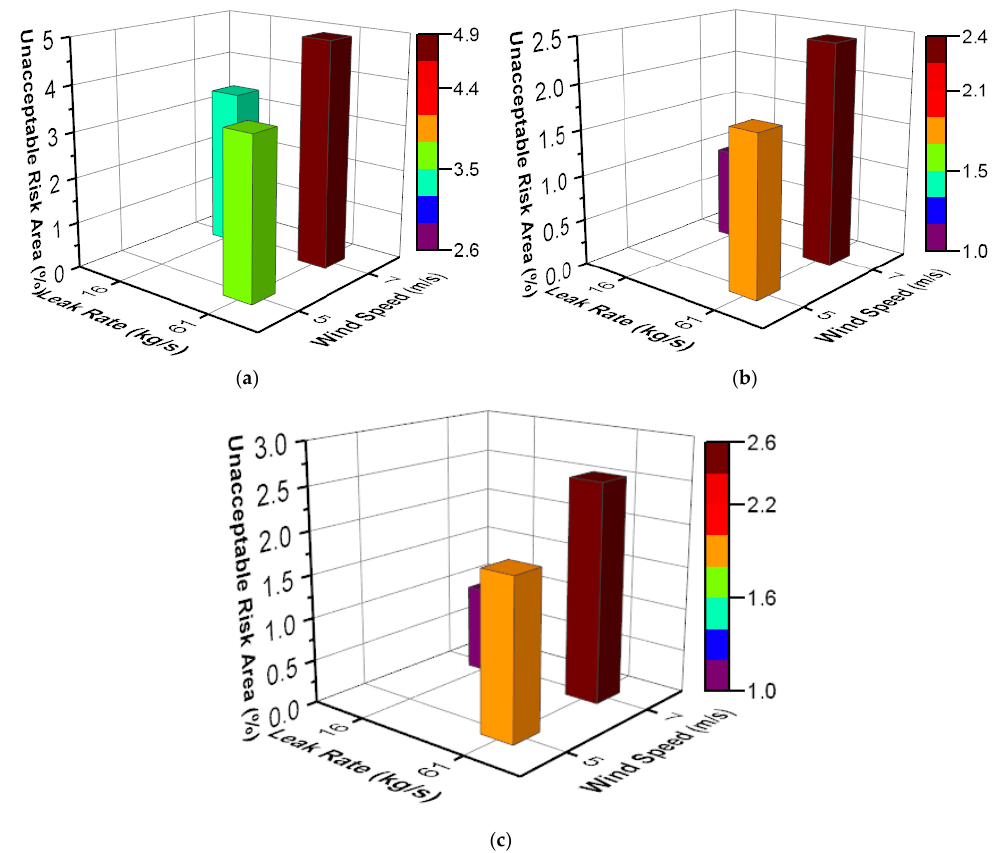
Figure 10. Unacceptable human fatality risk area for leak direction RZ- at year 1. ( a ) Head impact. ( b ) Lung damage. ( c ) Whole-body displacement.